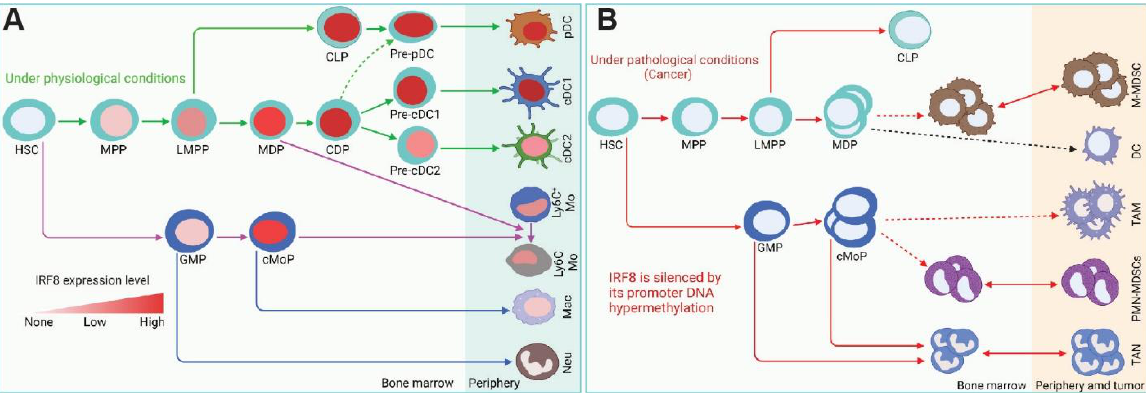
Figure 3. IRF8 functions under physiological and pathological conditions. ( A ). IRF8 regulation of myeloid cell lineage differentiation under physiological conditions. ( B ). Under pathological conditions such as cancer, IRF8 is silenced in myeloid cells, resulting in accumulation of immature myeloid cells and neutrophil. HSC: hematopoietic stem cell, MPP: multipotent progenitors, LMPP: lymphoid-primed multipotent progenitors, MDP: macrophage DC progenitors, CDP: common DC progenitors, CLP: common lymphoid progenitors, pDC: plasmacytoid DC, cDC1: conventional DC1, cDC2: conventional DC2, GMP: granulocyte-monocyte progenitor, cMoP: common monocyte progenitor, M-MDSC: monocytic-MDSC, PMN-MDSC: polymorphonuclear MDSC TAM: tumor-associated macrophage, TAN: tumor-associated neutrophils.